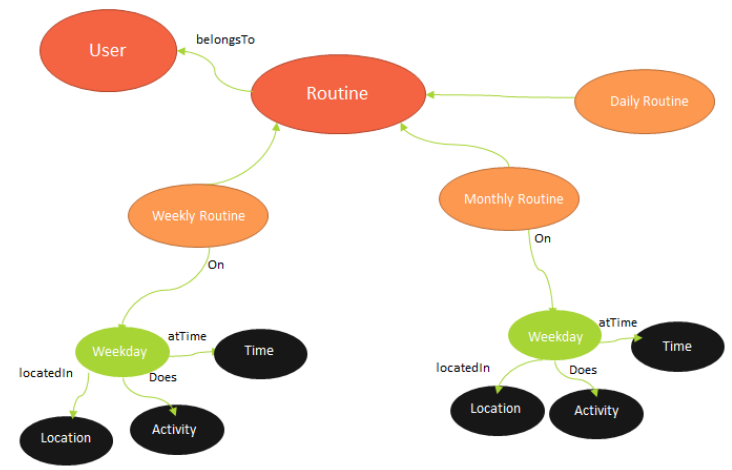
Figure 4. Structure of User Routine